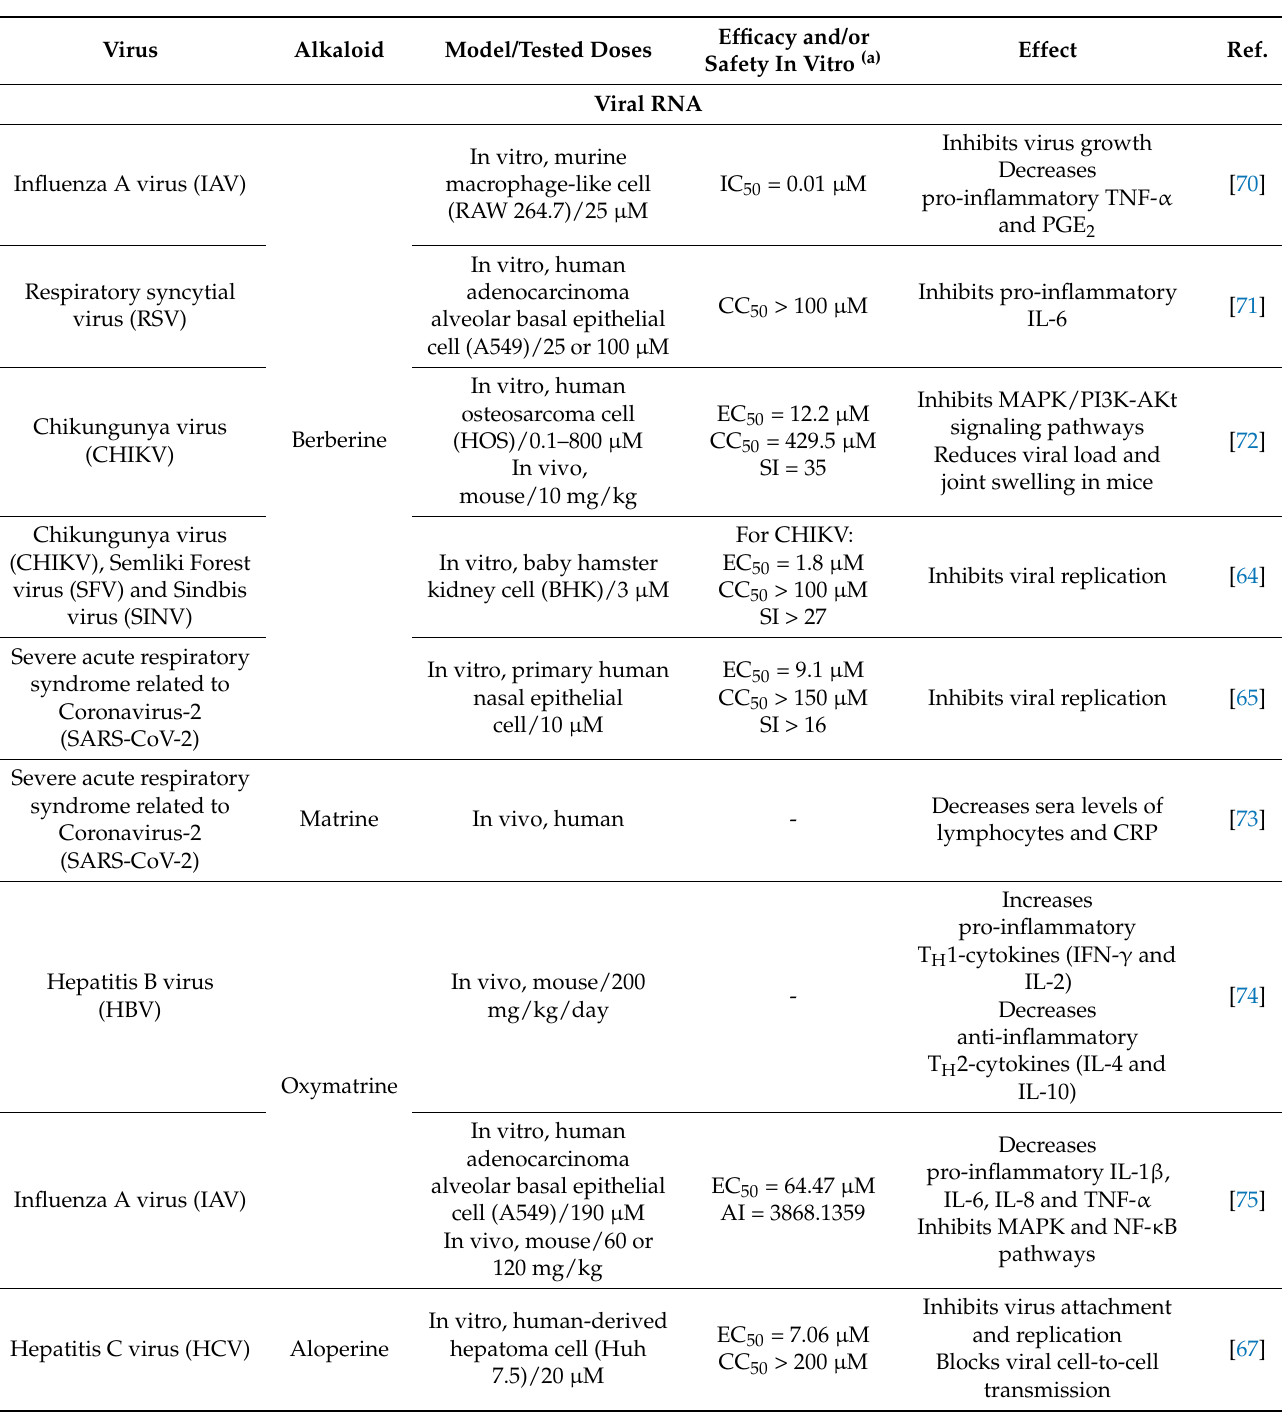
Table 1. Antiviral and immunomodulatory effects of alkaloids during viral